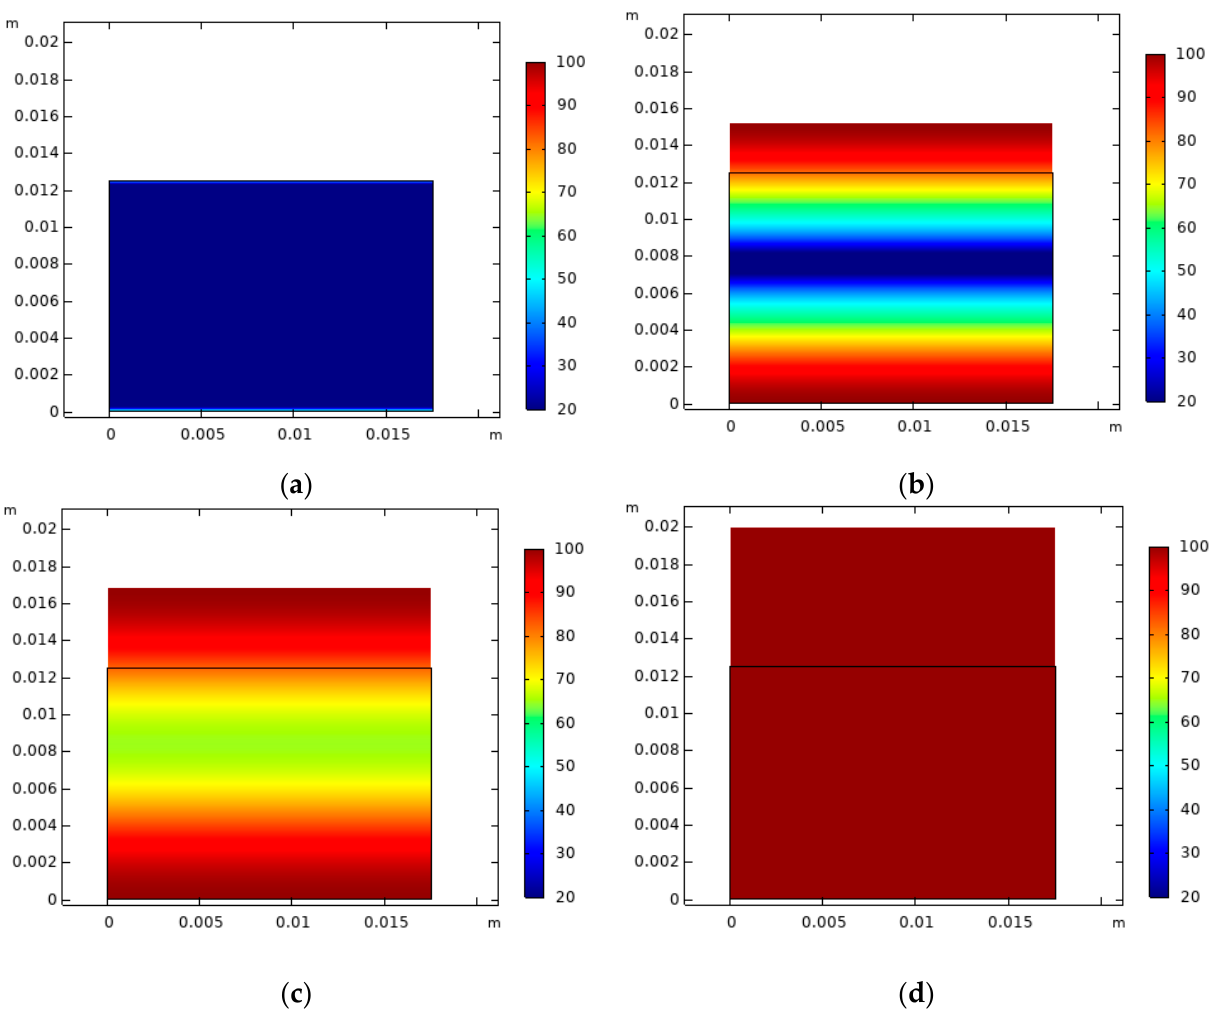
Figure 9. The degree of saturation of the sample at different times (( a ) t = 0, ( b ) t = 100 min, ( c ) t = 200 min, ( d ) t = 450 min) (under 21 kPa vertical stress (free swelling), Path ABCD, hydration stage AB).